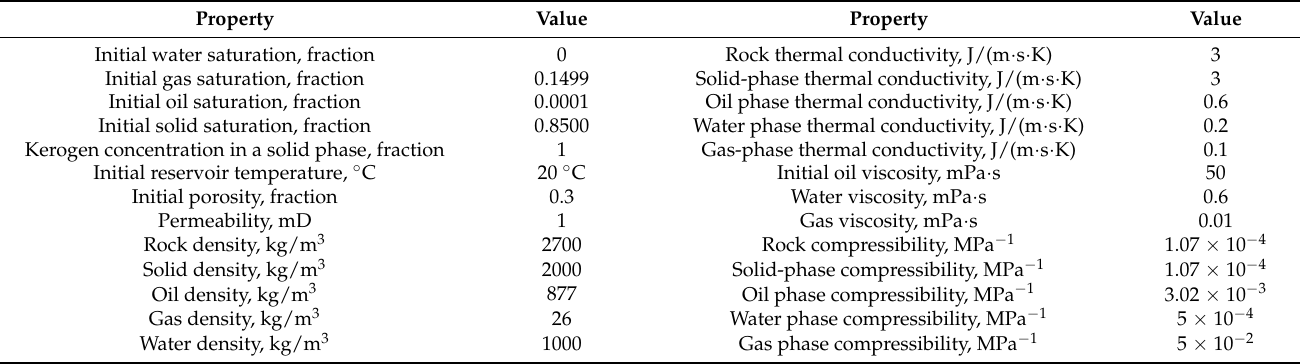
Table 2. Value physical